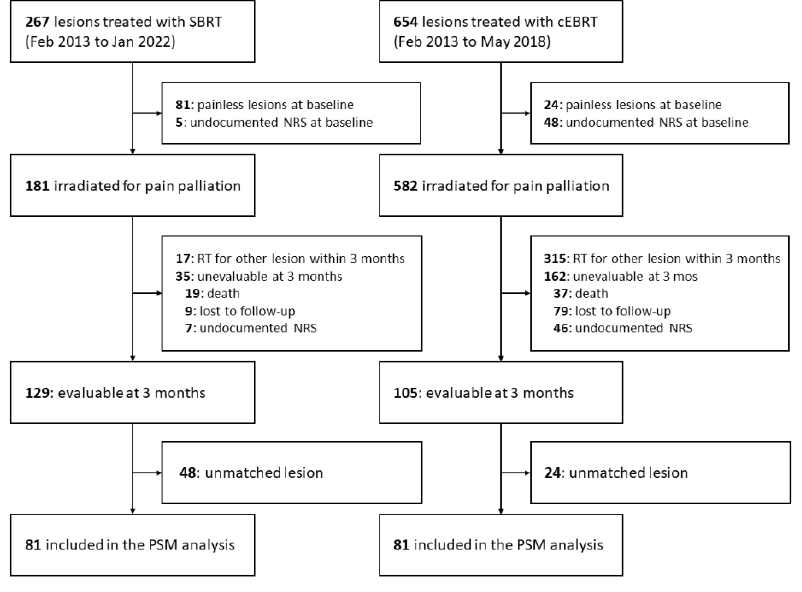
Figure 2. Study profile. Table 1. Patient and tumor characteristics of all lesions and matched